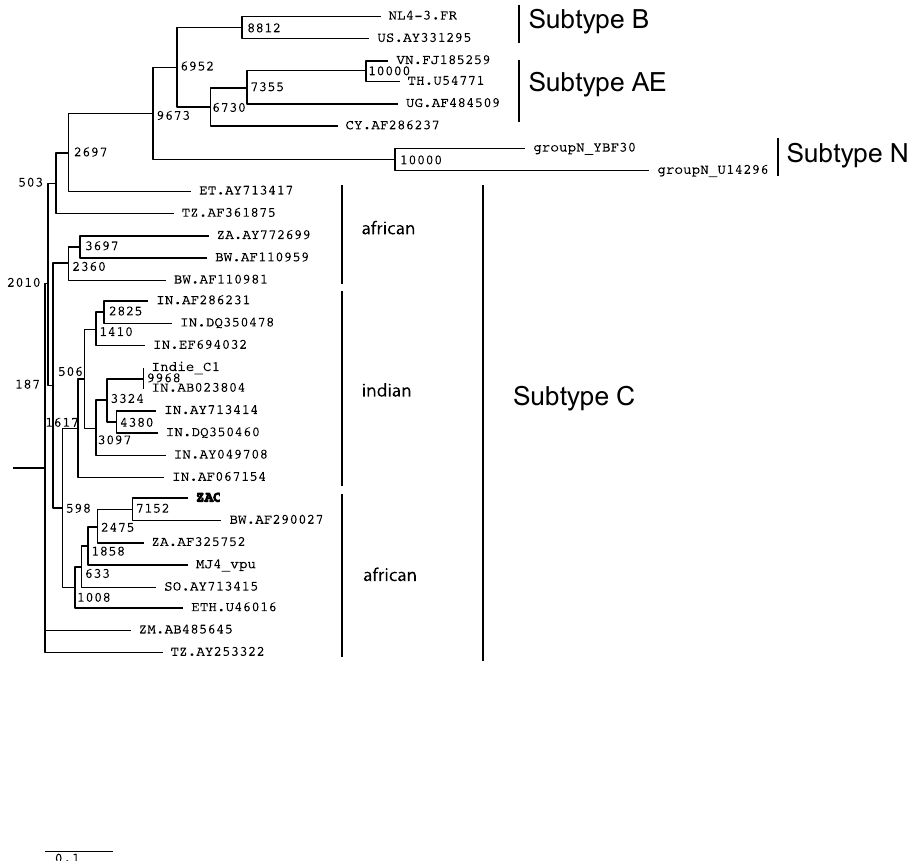
Figure 4. pZAC Vpu is unable to counteract CD317 but down-regulates CD4 expression at the cytoplasmic membrane. ( A ) Phylogenetic tree of the Vpu amino acid sequences. Evolutionary distances were calculated using the Maximum Composite Likelihood method, with a bootstrap test of 10,000 replicates. The branch scale, indicating the evolutionary distance, is indicated. The African subtypes do not form a unique cluster with the newly described pZAC sequence. Subtypes N, B, and AE were used as out-group. ( B ) pZAC is not completely able to counteract CD317. HEK 293T cells were co-transfected with pNL4- 3∆vpu, pZAC, or pMJ4 and 0.25 µg of pCD317. Cellular supernatants were titrated on TZM-bl cells and viral titers were determined. Experiments were performed in triplicate. Error bars indicate the standard deviation. ( C ) The pZAC Vpu is unable to rescue CD317 sensitivity of pNL4- 3∆vpu to wild type levels. MJ4 Vpu is significantly better at antagonising CD317 than that of ZAC Vpu. HEK 293T cells were transfected with pNL4- 3∆vpu and pZAC vpu or pMJ4 vpu . Viral titers were determined on TZM-bl cells. Bars represent the mean of 3 independent experiments. ( D ) pZAC and pMJ4 are able to down-regulate CD4 expression in a similar way. HEK 293T cells were cotransfected with the CD4 expression construct pMSCCD4 and pZAC vpu or pMJ4 vpu . CD4 expression was monitored by FACS. CD4 expression of the control without vpu was set to 100%. Bars represent the mean of 3 independent experiments. Error bars indicate the standard